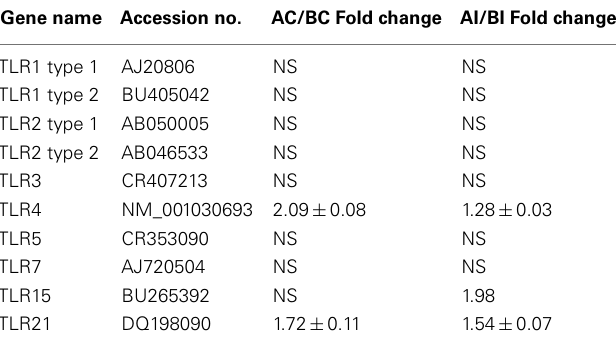
Table 3 | Fold change ofToll-like receptor genes between heterophils isolated from lineA and B chickens using qRT-PCR analysis.